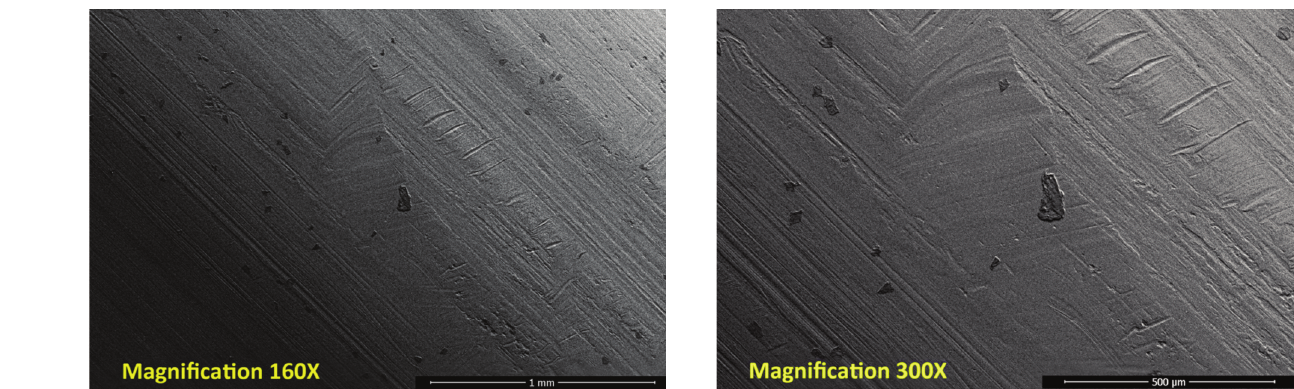
SEM image from inferior ridge of the FNE from Patient 1 Fig. 3: with medial migration showing both transverse scratch marks and longitudinal scratch marks. Transverse marks seen only on the apex of the inferior ridge limited to the specific segment of the FNE that traversed through the intramedullary component during medial migration.